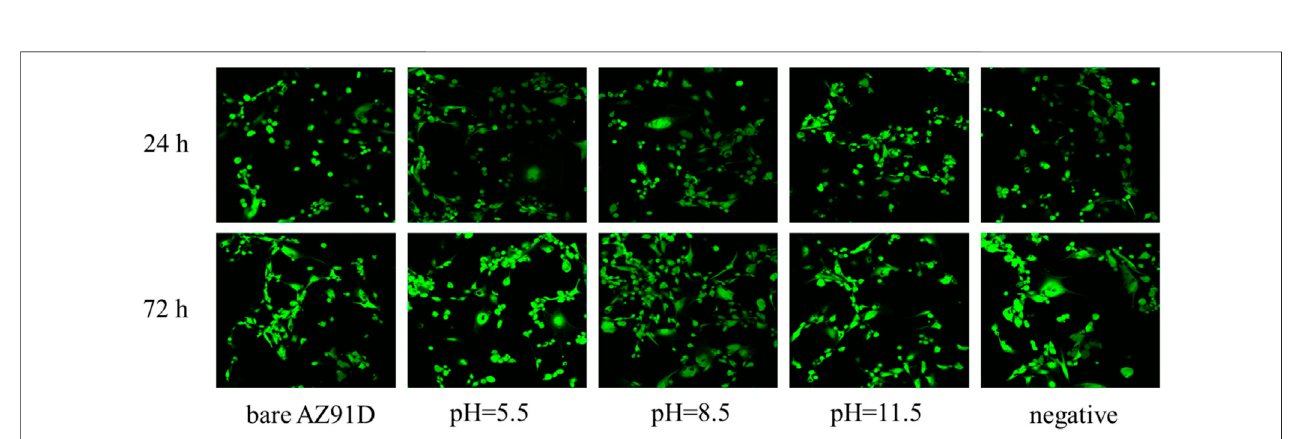
FIGURE 13 | Confocal fl uorescence images of human SV40 transfected osteoblasts after co-incubation for 24 and 72 h in various groups.